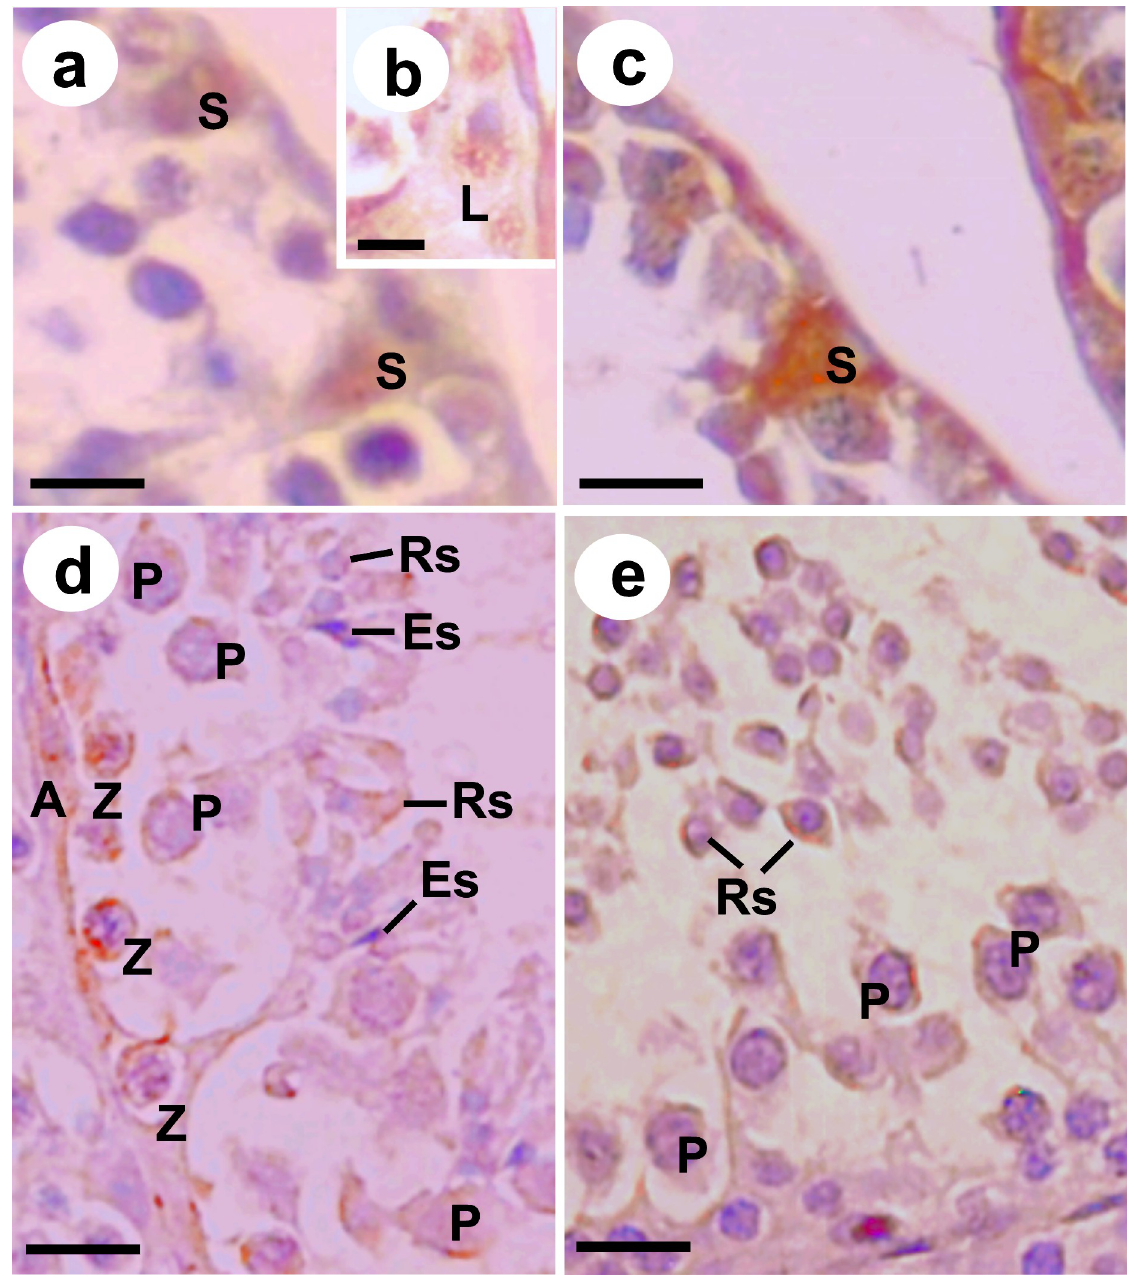
Fig 5. Immunohistochemical detection of androgen (a-b), aromatase (c), FGF2 (d) and BCL-2 (e) receptors on Diphylla ecaudata testes. S: Sertoli cell nuclei; L: Leydig cell cytoplasm; A: Type A spermatogonia; Z: zygotene primary spermatocyte; P: pachytene primary spermatocyte; Rs: round spermatid; Es: elongated spermatid. Scale bars: 30 μ m.